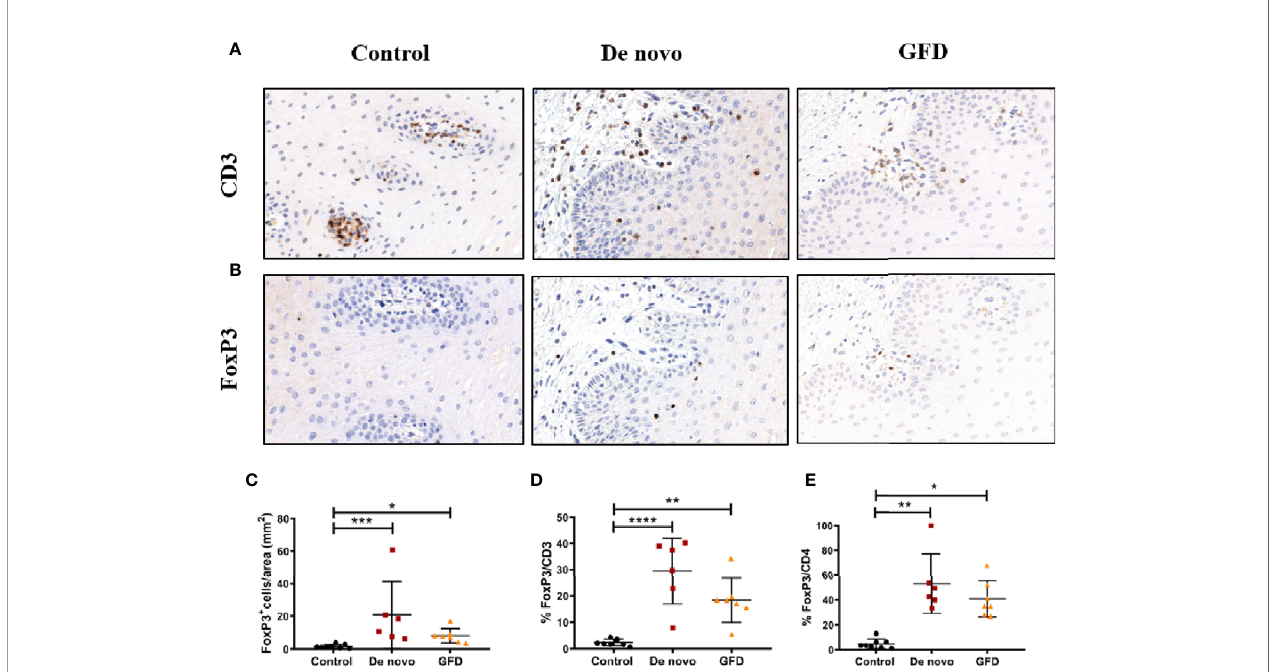
FIGURE 3 | Representative images of CD3 (A) and FoxP3 (B) staining of oral mucosal sections. Images were captured at 20× magni fi cation. Quanti fi cation of FoxP3+ cells in the whole mucosa (C) for non-celiac subjects (control) (n = 8) and celiac disease patients de novo diagnosed ( de novo ) (n = 6) and after Gluten Free